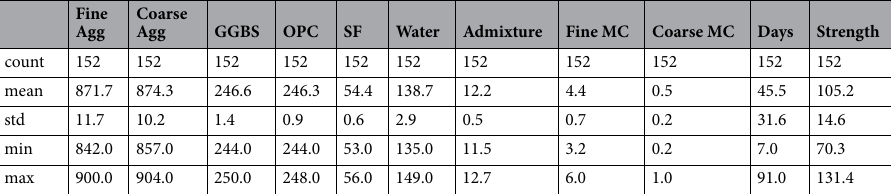
Table 2. Summary of statistical analysis of the concrete material